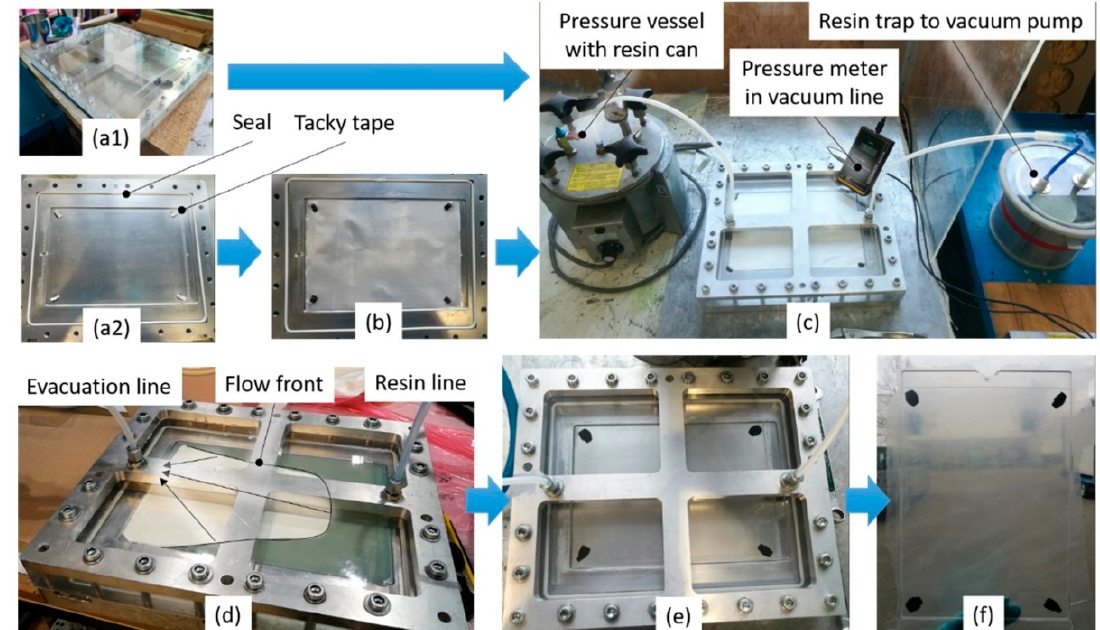
Figure 5. The RTM setup and its processing states: ( a1 ) upper PMMA-mold, ( a2 ) lower aluminum mold, ( b ) reinforcement in the cavity, ( c ) assembled mold, ( d ) resin injection, after 24 h of ( e ) cure, and ( f ) the demolded part.